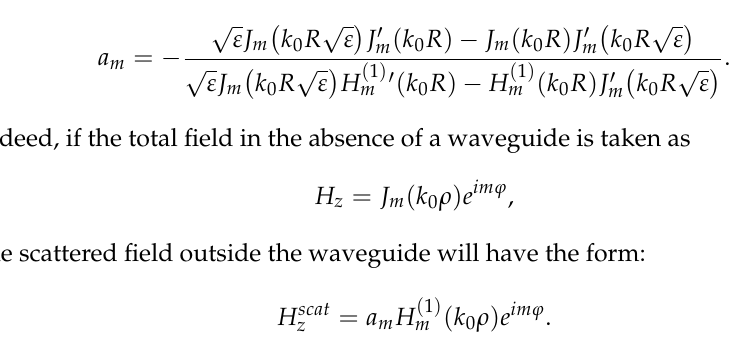
Figure 2. Dependence of Re [ H z ( ϕ = 0 )] on (cid:112) ρ / R for the perfect invisibility (PTM (11)) and for the usual quasi-normal (TM 11 ) mode in a circular cylinder with permittivity ε =